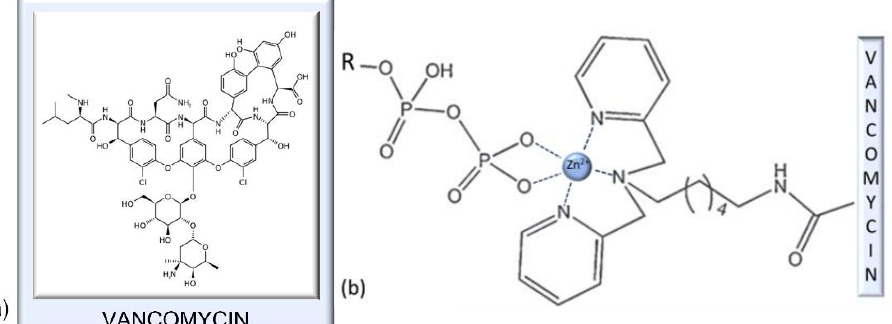
Figure 7. ( a ) Structure of vancomycin, a glycopeptide antibiotic. ( b ) Zinc chelate of dipicolyl–vancomycin conjugate and pyrophosphate groups of cell-wall lipids. Inspired by ref. [50] .